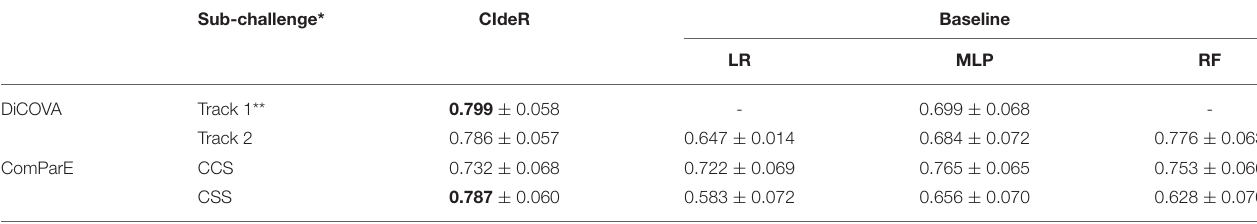
TABLE 3 | Results for CIdeR and a range of baseline models for 4 sub-challenges across the DiCOVA and ComParE challenges.